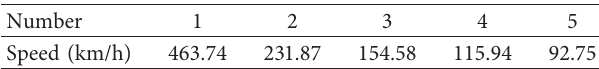
Figure 11: The maximum acceleration of the bridge midspan under the four models at a speed of 460km/h. Table 3: The results of resonance critical